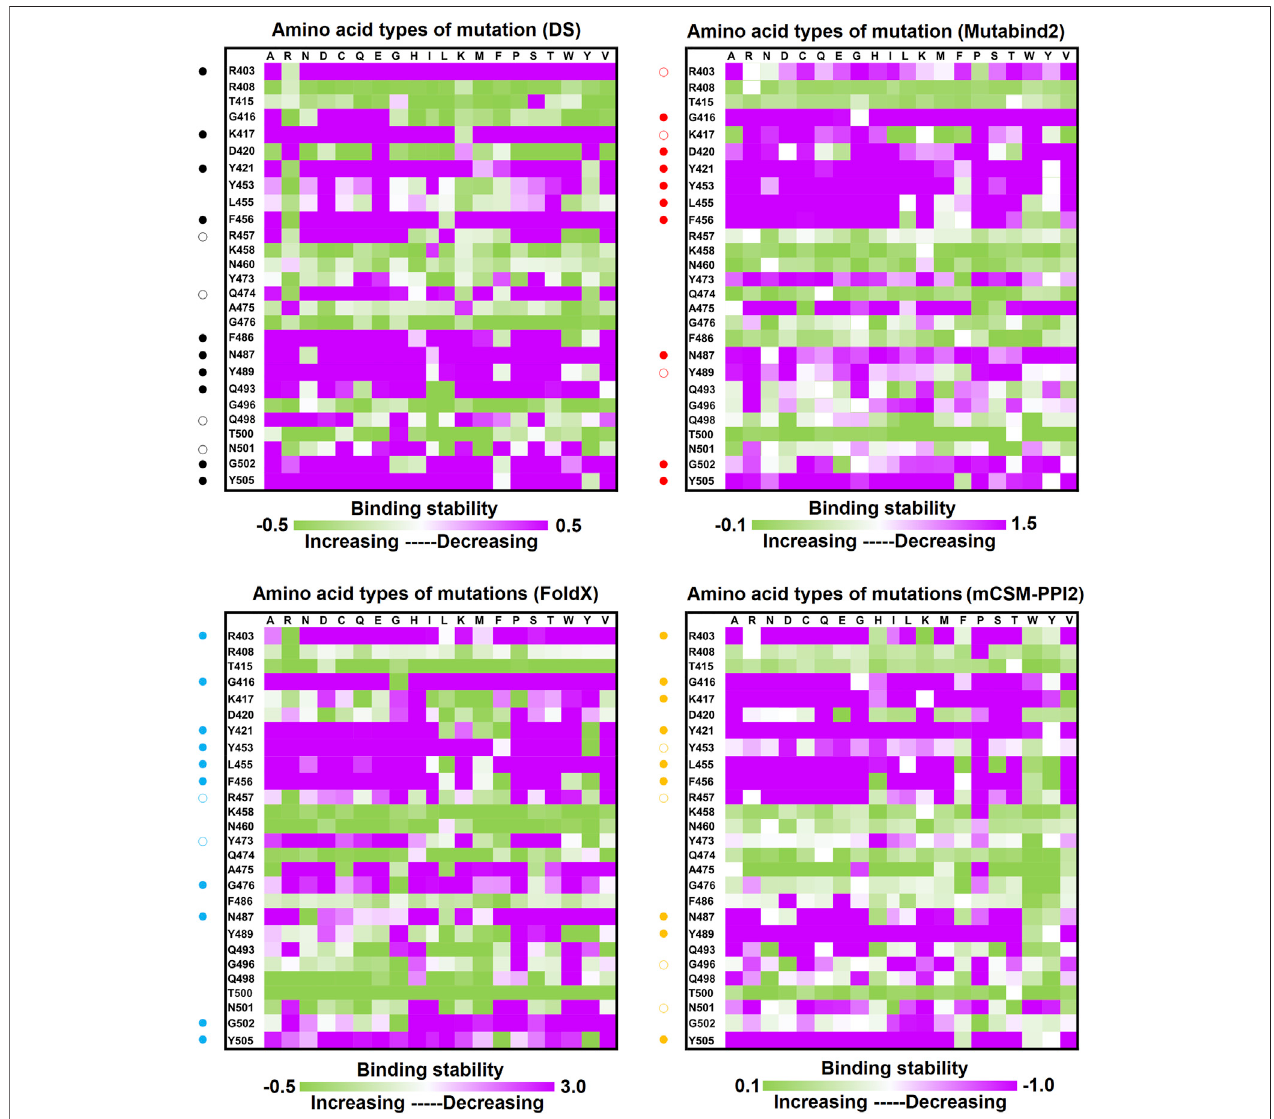
FIGURE9| MutationalheatmapsoftheRBDtargetingantibodyCA1-B3.ThemutationalbindingstabilitiesofRBDvariantstoCA1-B3wereestimatedusingFoldX, MutaBind2, DS 3.5, and mCSM-PPI2. The unit of binding stability was kcal/mole, and the obtained values were employed to create the heatmaps. Green (increased stability) and purple (reduced stability) were used to generate a color gradient and were applied in each box. In each heatmap, the moderately and signi fi cantly reduced stabilities were labeled with hollow and solid circles, respectively.